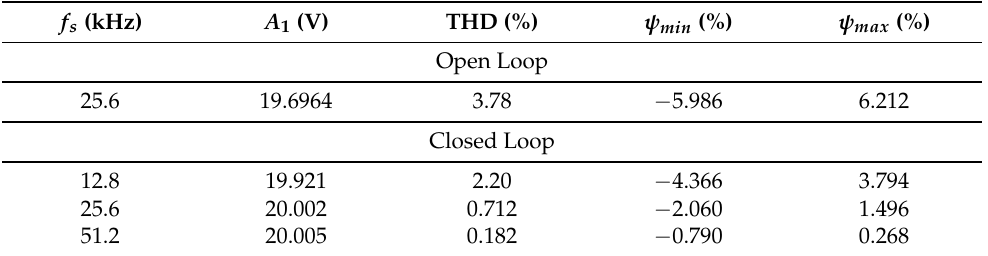
Figure 8. The distortion function ψ and THD values obtained from QCT and PWM simulation models. Top row: uncontrolled system, bottom row: PID controlled system. Green lines: QCT simulation, blue lines: PWM simulation. Table 1. Amplitude A 1 , THD, and the extremum values of the distortion function ψ ( t )